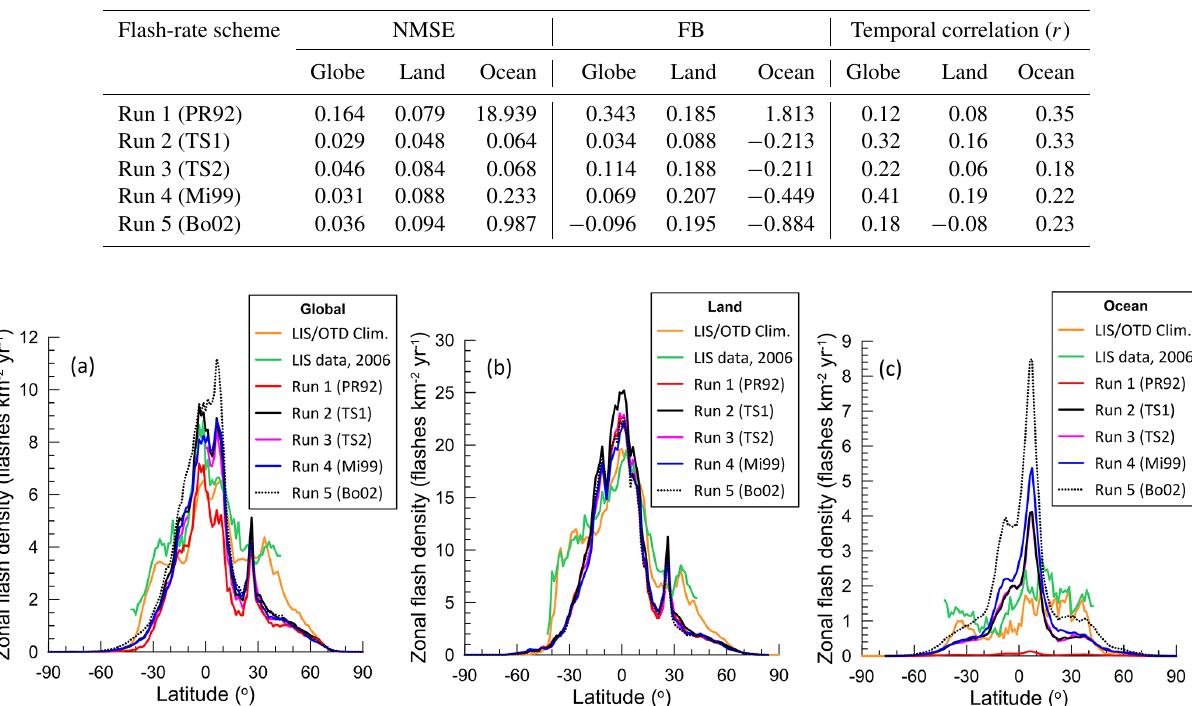
Figure 4. Observed and modelled zonal mean flash densities (flasheskm − 2 yr − 1 ) from the five model runs over the (a) globe, (b) land, and (c) ocean. The observations are the LIS/OTD climatology and the LIS data for the year